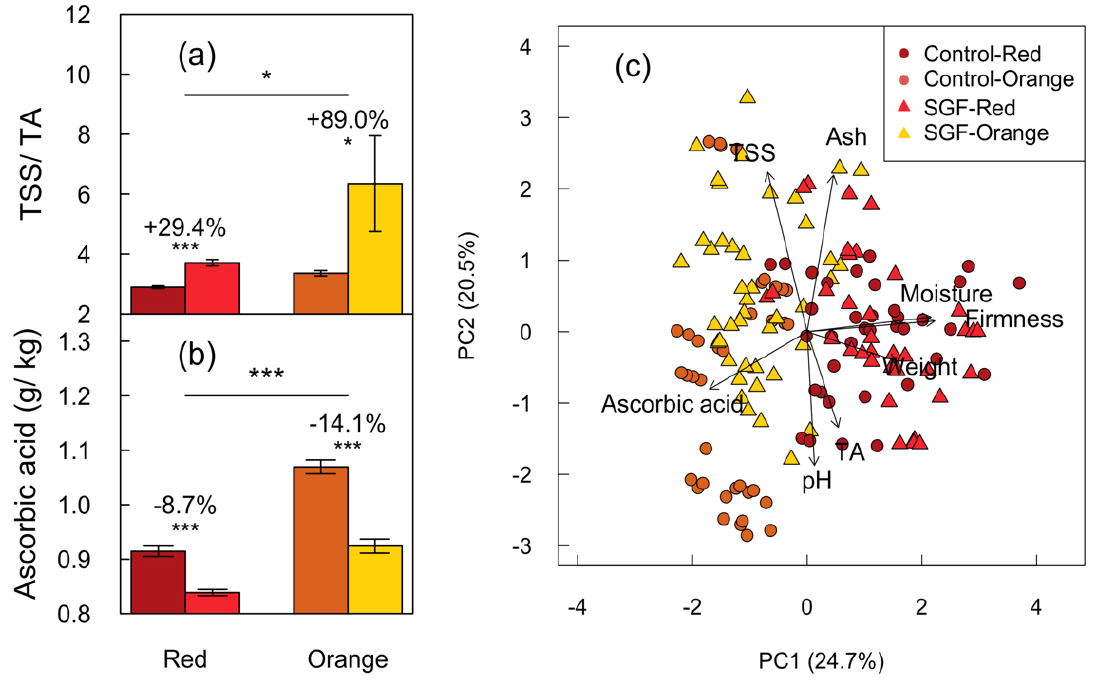
Figure 3. Analysis of postharvest quality parameters in Red and Orange fruits grown under SGF. ( a ) Total soluble solids (TSS) to titratable acids (TA) ratio (TSS/TA). ( b ) Ascorbic acid content in fruits (g/kg of fruit tissue). ( c ) Principal component analysis (PCA) showing multivariate associations among quality indexes. PC1 (24.7%) and PC2 (20.5%) define the cultivar specific differences in quality parameters. Standard error bars are shown ( n = 12). Horizontal lines and stars denote statistical significance analyzed by one-way ANOVA (*; p ≤ 0.05 and ***; p ≤ 0.001).